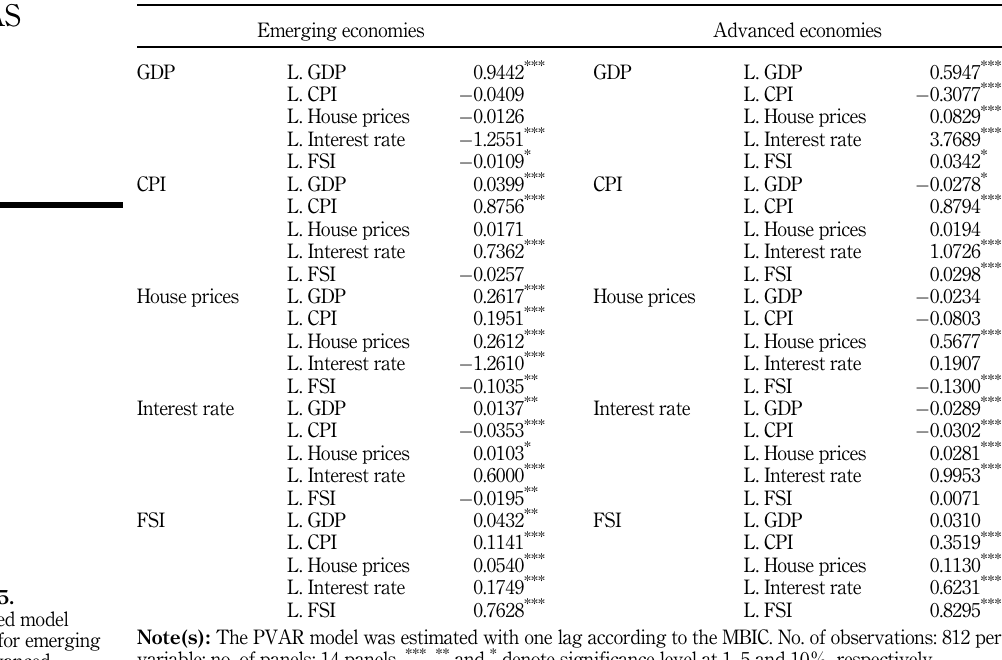
Table 5. Extended